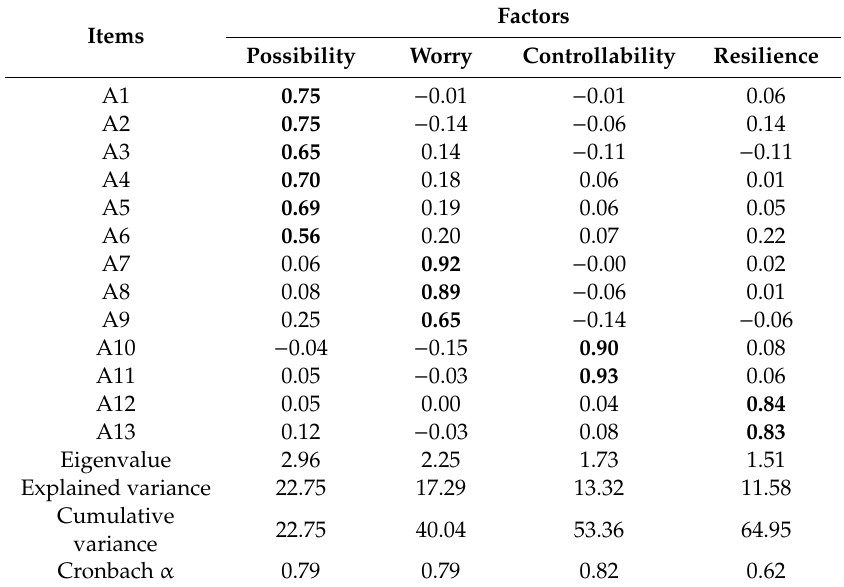
Table 4. Component matrixes of risk perception after